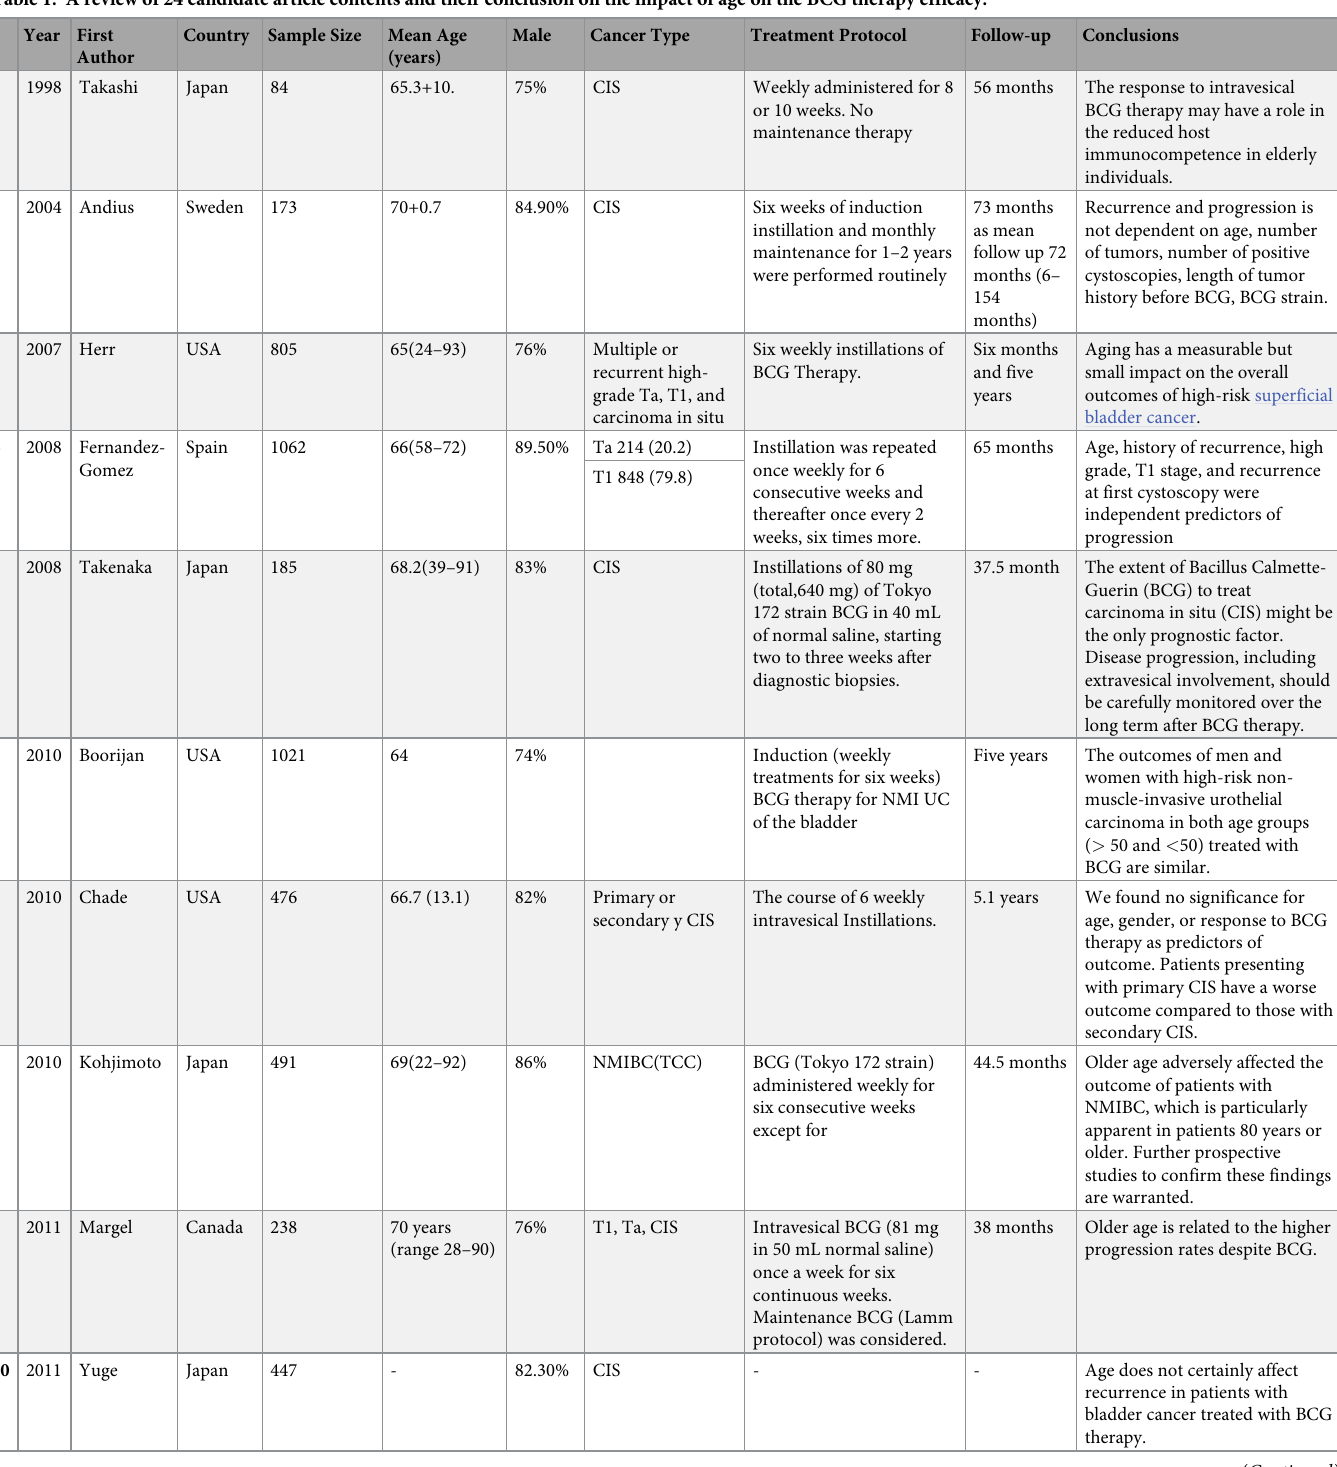
Table 1. A review of 24 candidate article contents and their conclusion on the impact of age on the BCG therapy